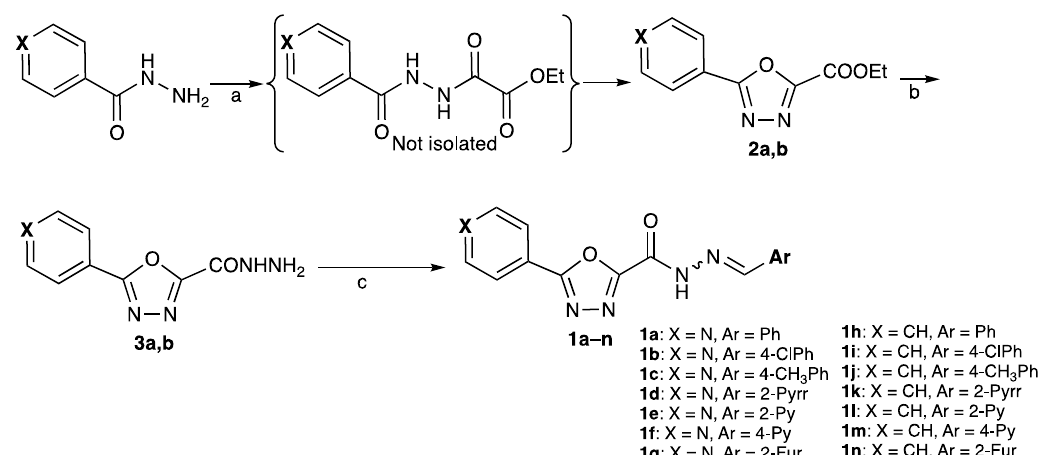
Scheme 1. Synthetic route of title compounds 1a–n . Reagents and conditions: ( a ) ClCOCOOEt, Et 3 N, DCM, 0 ◦ C to rt, then Et 3 N, p -TosCl, DCM, rt; ( b ) H 2 NNH 2 , EtOH, reflux; ( c ) appropriate aromatic or heteroaromatic aldehyde, EtOH, AcOH (cat),